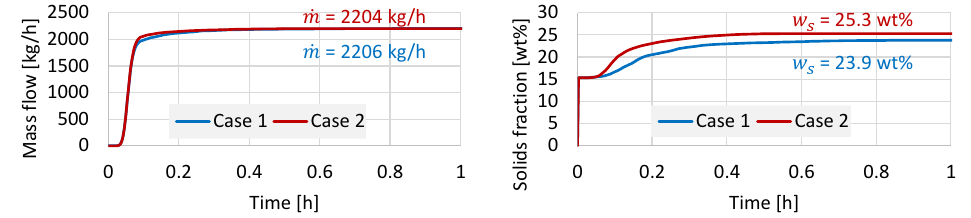
Figure 15. Time-dependent change in mass flow ( left ) and solids fraction ( right ) in the outlet stream of Centrifuge 1 (Concentrate 1 stream in Figure1) for each case study.